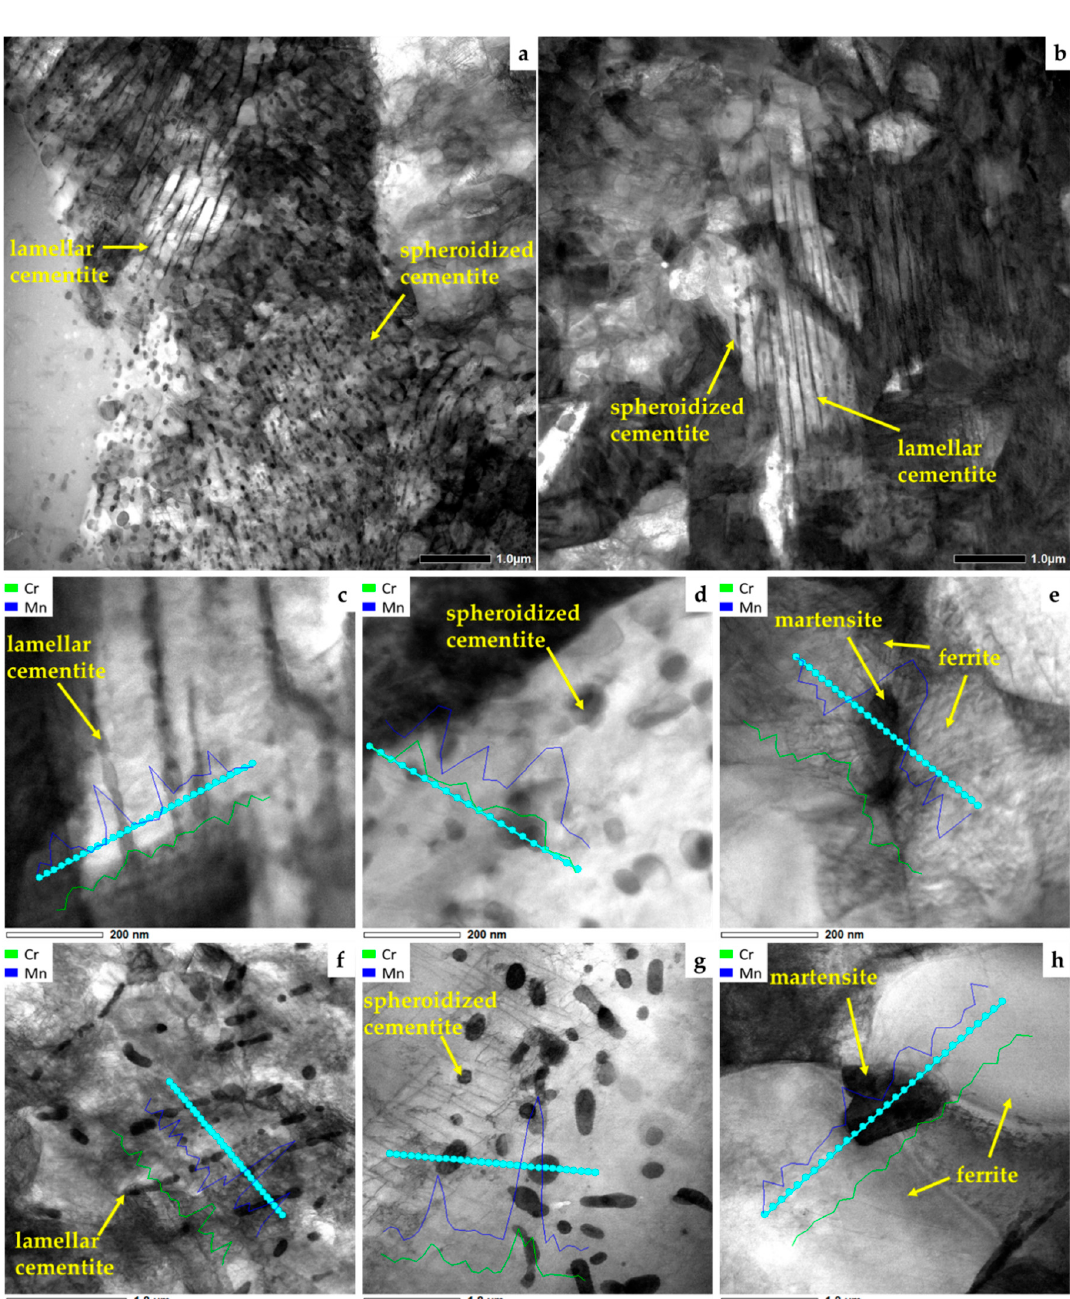
Figure 5. Bright field scanning transmission electron microscopy (BF-STEM) images of the ( a ) CH and ( b ) UFH sample showing undissolved pearlitic colonies. In both samples, the cementite is found in lamellar or spheroidized forms. ( c , d ) STEM images of spheroidized and lamellar cementite in the UFH sample with EDXS line scans showing higher concentration of Cr and Mn in cementite. ( e ) STEM image of the UFH sample with EDXS line scan showing the segregation of Cr and Mn on the ferrite grain boundaries. ( f , g ) The mass % intensity of Cr and Mn in lamellar and spheroidized cementite in the CH sample while ( h ) shows no segregations of Cr and Mn between martensite and two ferrite grains. The small peaks are due to noise inside the TEM chamber.